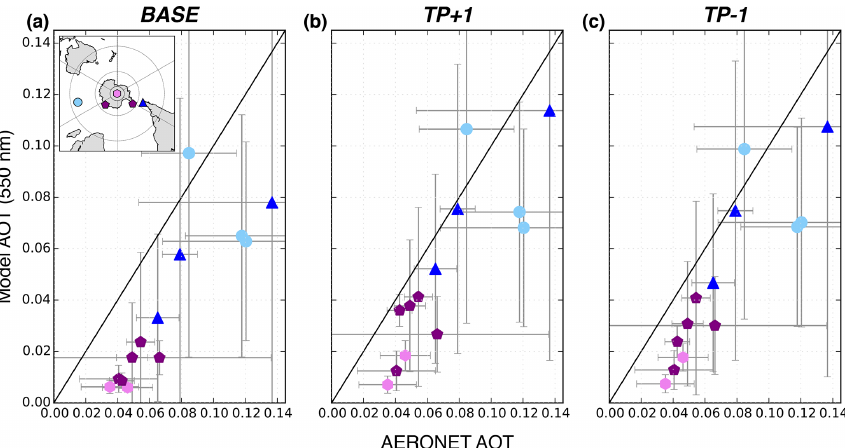
Figure 3. Scatter plots of observed versus simulated monthly mean 550nm AOT at southern mid- and high-latitude AERONET stations for January to March 2020. The error bars represent the standard deviation based on daily values. Compared are model results for the cases (a) BASE , (b) TP + 1 , and (c) TP − 1 . The stations are color-coded respectively: Punta Arenas, Chile (53.14 ◦ S, 70.89 ◦ W), blue triangle; Amsterdam Island (37.80 ◦ S, 77.57 ◦ E), light blue circles; Marambio (64.24 ◦ S, 56.63 ◦ W) and Vechernaya Hill (67.66 ◦ S, 46.16 ◦ E), purple pentagons; South Pole (90.00 ◦ S), light purple hexagons.